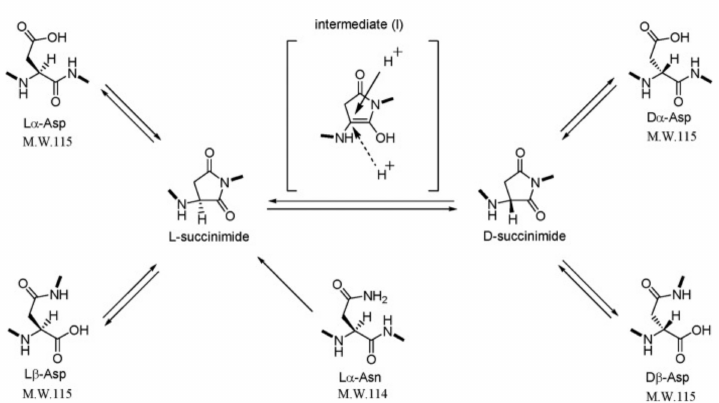
Figure 1. Possible reaction pathways for spontaneous isomerization of Asp and deamidation of Asn residues in protein. Reproduced with permission from the authors of [60].